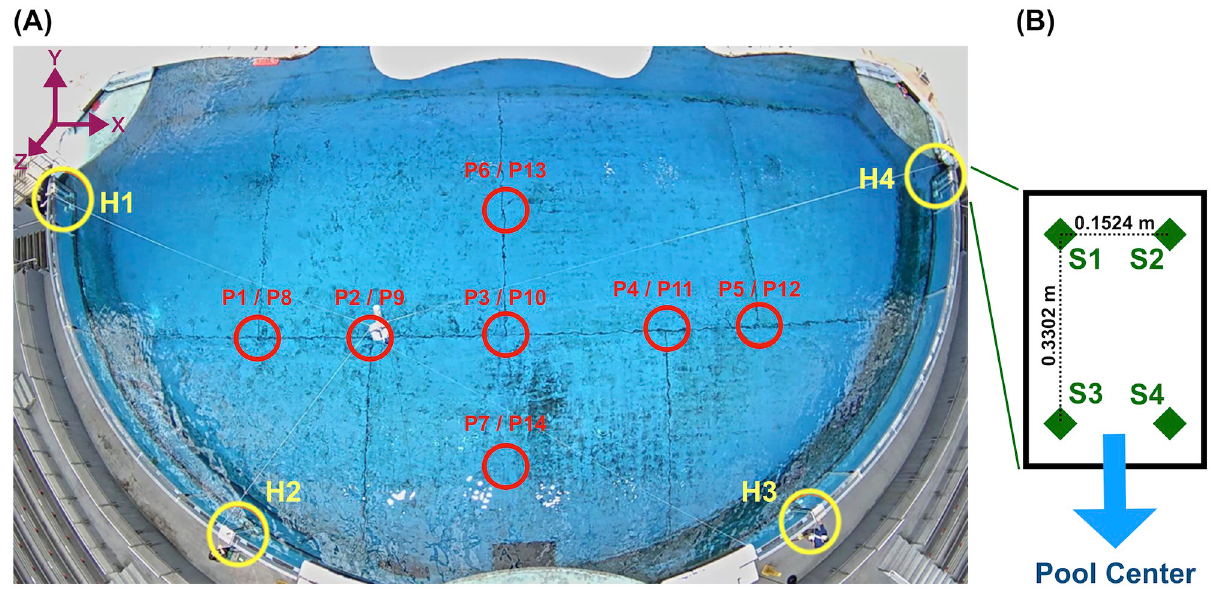
Fig 2. Layout of the tonal source locations and the four 4-hydrophone-arrays. (A) The National Aquarium Exhibit Pool (EP) is shown, as visualized by an overhead AXIS P1435-LE camera. Circled in red are the approximate surface projections of the 14 source locations at which tonals were played; each circle represents both a shallow and deep source location, corresponding to the two forward-slash-separated identifiers adjacent each circle. Circled in yellow are the four 4-hydrophone arrays, with adjacent identifiers. (B) The simplified face of a hydrophone-containing panel from one 4-hydrophone-array. Green diamonds represent approximate hydrophone positions, with local addresses